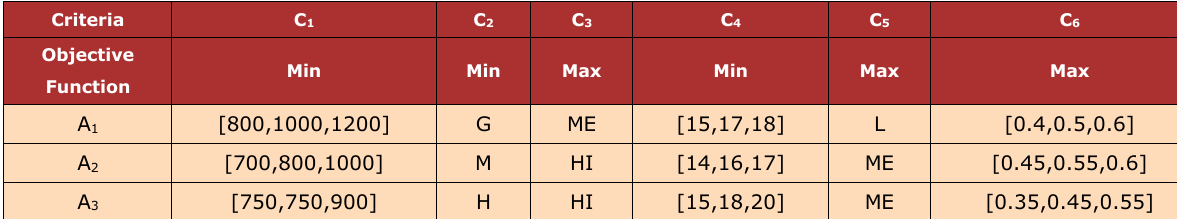
Table 5. Fuzzy numbers and qualitative statements related to every C j in every A i